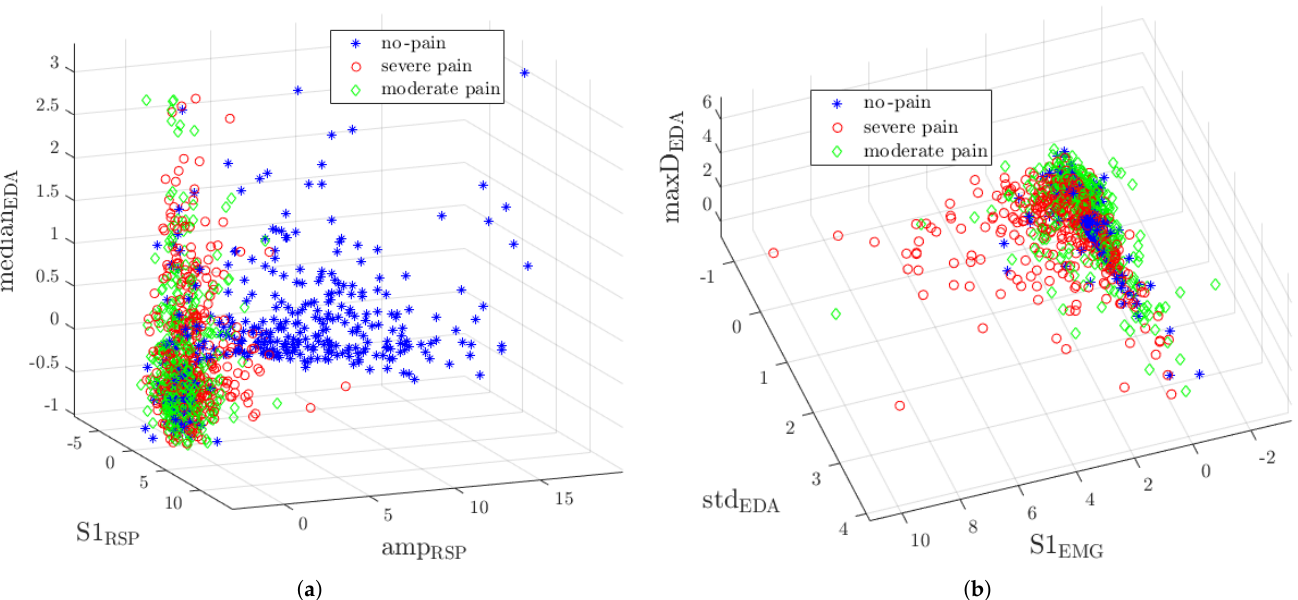
Figure 5. The distributions of representative cases in three-dimensional feature space: ( a ) presents well separable no-pain observations (amplitude of respiratory (RSP), the S 1 energy of RSP and median of electrodermal activity (EDA) distribution), ( b ) reflects partial overlaping of severe and moderate pain classes ( S 1 energy of EMG, standard deviation of EDA, and maximum of EDA 1st derivative